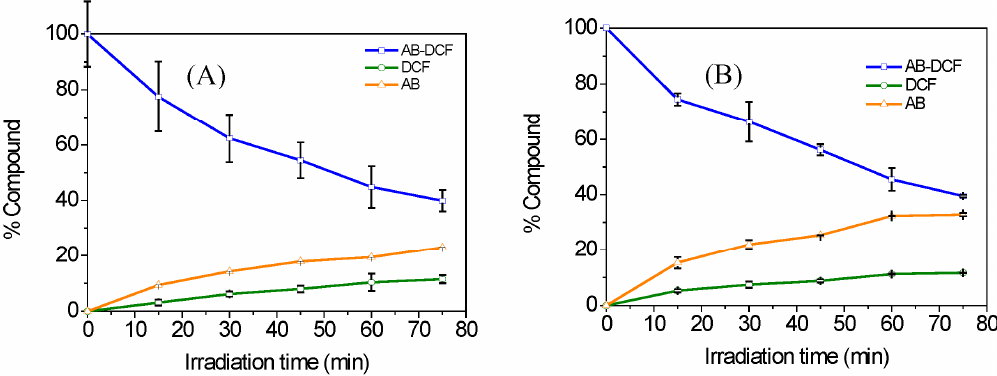
Figure 4. Time course of SSL irradiated samples of ( A ) AB–DCF in EtOH/N 2 , ( B ) AB–DCF in dEtGly/air.